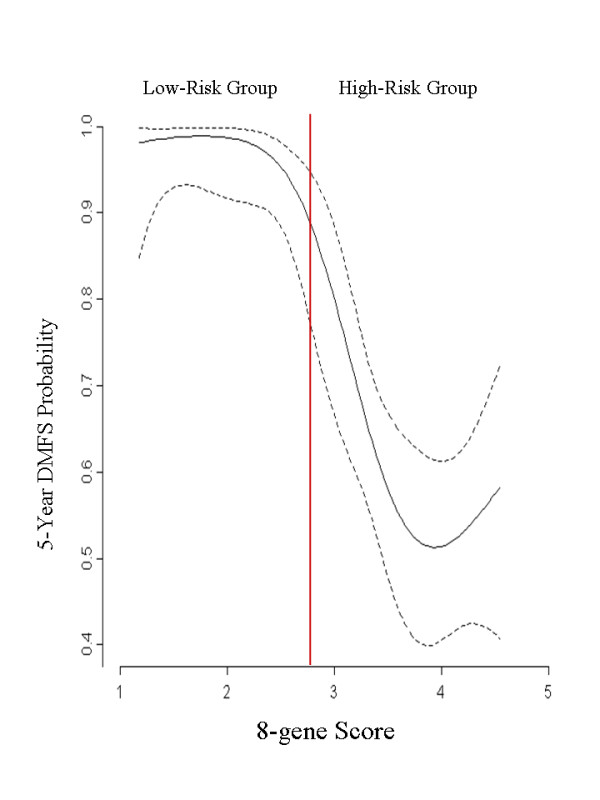
Distant metastasis-free survival (DMFS) rates as a continuous function of the 8-gene Score. The red line indicates the cutoff point. Dashed lines indicate the 95% confidence interval.